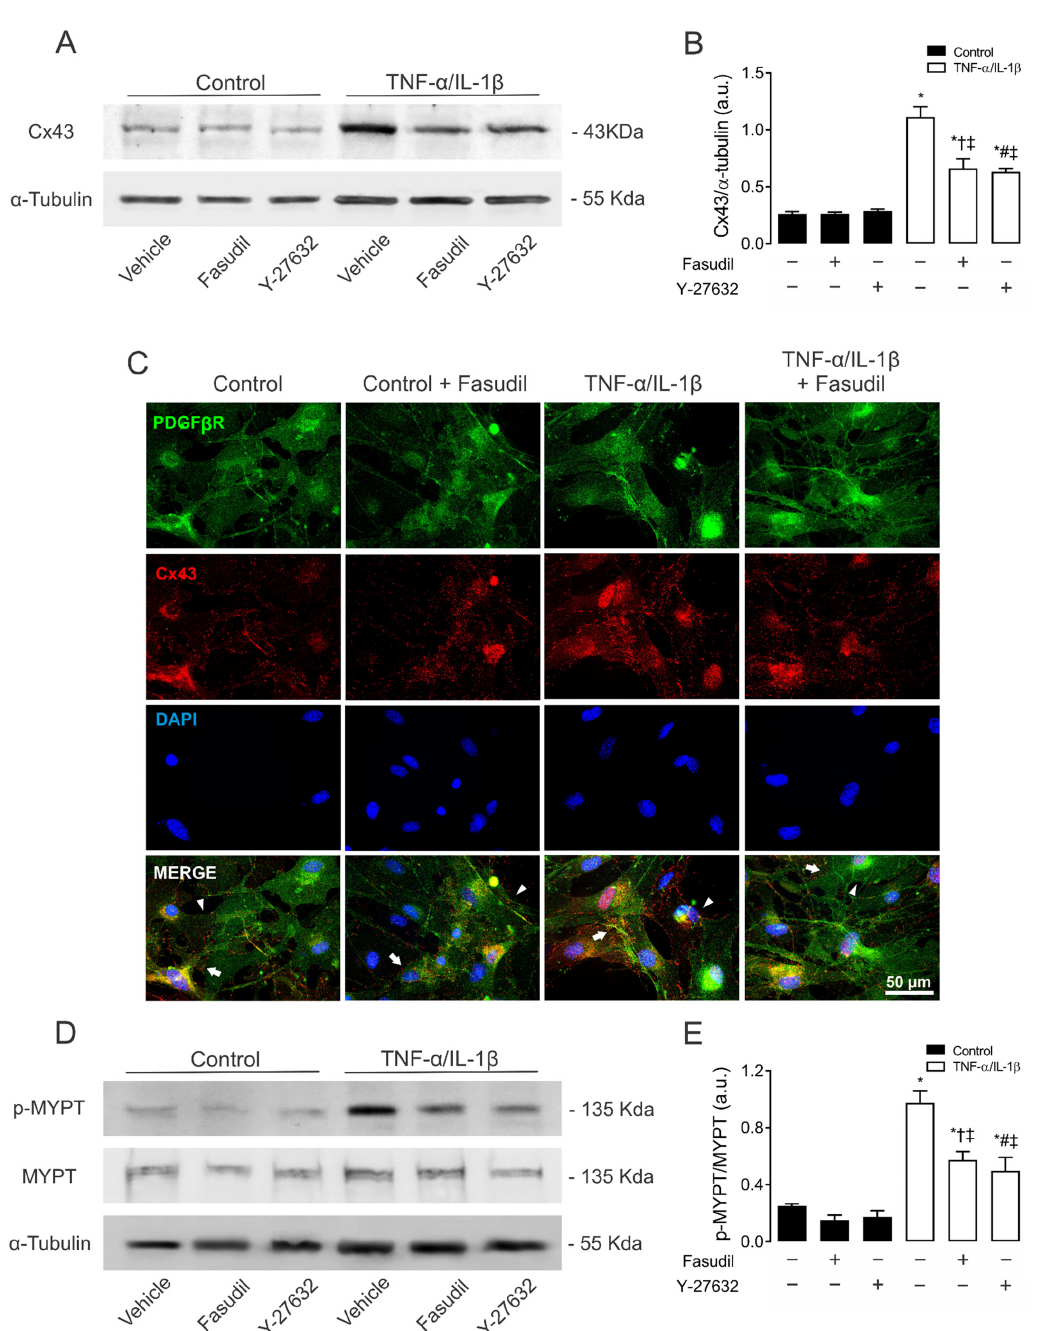
Figure 4. Blockade of ROCK prevents the increase in connexin43 and phosphorylated MYPT in mesangial cells induced by TNF- α /IL-1 β . ( B ) Graphs show the relative amount of Cx43 and ( E ) phosphorylation of MYPT-1 determined by Western blotting analysis in MES-13 cells under control conditions (black bars) or exposed to TNF- α /IL-1 β (white bars) for 72 h. ( C ) Fluorescence images depicting PDGF β R (green), Cx43 (red) and DAPI (blue) staining of primary MCs stimulated for 72 h with 10 ng/mL TNF- α /IL-1 β . White arrows indicate GJ plaques at cell–cell interfaces, and white arrowheads indicate Cx43 HCs. Calibration bar: white = 50 µ m. Fasudil (15 µ M) or Y-27632 (15 µ M) was added 24 h before harvesting the cells. Each bar represents the mean value ± SEM of ≥ 3 independent experiments. Statistical significance * p < 0.05 vs. Ctrl; † p < 0.05 vs. Control + Fasudil; # p < 0.05 vs. Control + Y-27632; ‡ p < 0.05 vs. TNF- α /IL-1 β . Next to the graph, representative pictures of Cx43 ( A ), phosphorylated MYPT (p-MYPT), unphosphorylated MYPT positive bands ( D ), and its loading control ( α -tubulin) are